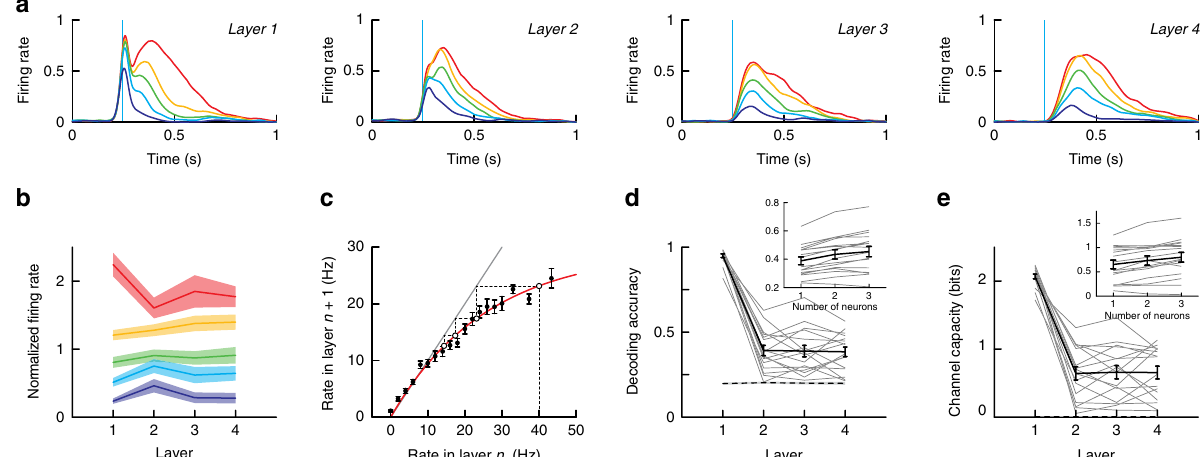
Fig. 5 Propagation of fi ring rate information. a Average PSTHs in layers 1 – 4 (left to right) compiled from trials sorted in fi ve groups based on fi ring rates in layers 1 (see text and Methods). b Firing rate vs layer. For each neuron of each network, the fi ring rate was normalized by the average rate across the different groups. c Logistic map showing output rate ( = fi ring rate in layer n + 1) versus input rate ( = fi ring rate in layer n ). The gray line has a slope of 1 and the red curve is a fi t to the data. Dotted lines represent a sample trajectory starting at 40 Hz in layer 1 and ending at 13 Hz in layer 4. d Decoding accuracy quanti fi ed as the probability of correctly classifying fi ring rate in the fi rst layer given the fi ring rate in the n th layer. Inset shows the decoding accuracy when 1, 2 or 3 neurons from layers 2 – 4 where used simultaneously to decode the fi ring rate in layer 1. Paired t -test statistic for the increase in decoding accuracy with the number of neurons: 1 vs 2: P = 1.1 × 10 − 5 , 1 vs 3: P = 1.1 × 10 − 4 , 2 vs 3: P = 0.012. e Same as in d for the channel capacity. Paired t -test statistic for the increase in channel capacity with the number of neurons: 1 vs 2: P = 0.002, 1 vs 3: P = 2.1 × 10 − 4 , 2 vs 3: P = 0.004. Data are compiled from the same n = 16 dense networks of Fig. 2 and are presented as mean ± SEM. In d , e all data are shown as thin